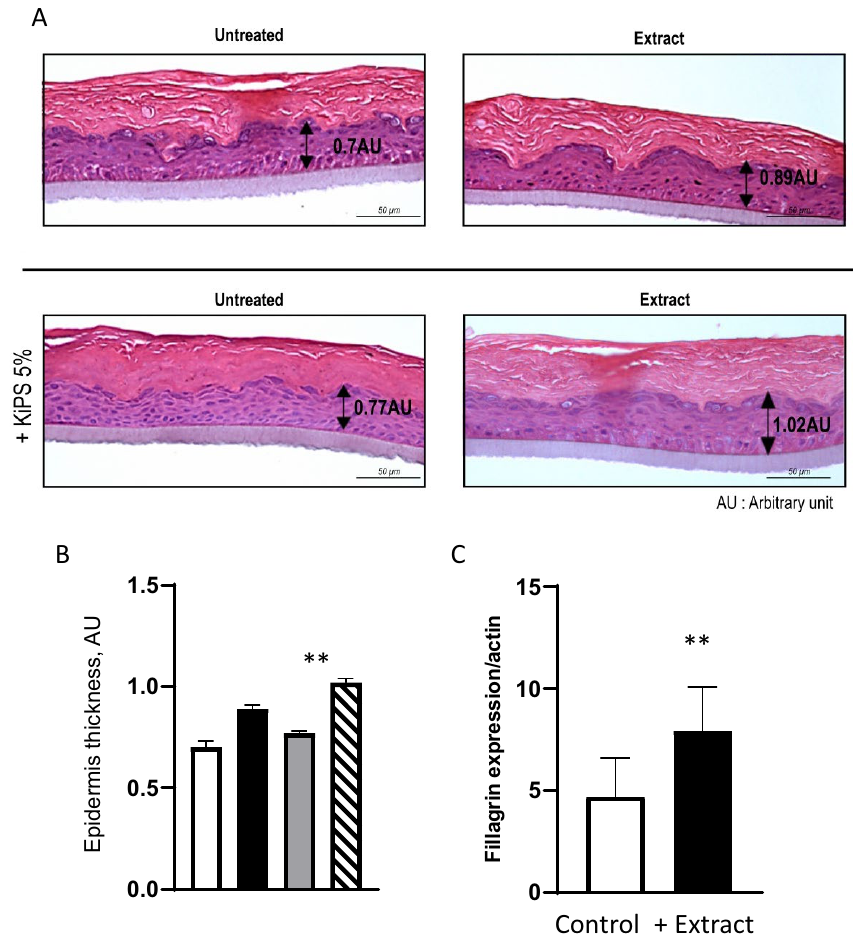
Figure 4. Morphological study of RHE-KiPS after treatment with plant extract. ( A ) Hematoxylin and Eosin staining at Day 13 to study RHE morphology: hematoxylin stains basophilic structures such as the nuclei in blue and purple; Eosin stains acidophilic structures such as the cytoplasm in pink. The upper panel shows RHEs derived from 100% non-treated (left) or pre-treated NHKs (with 1% JPPS extract treatment 48 h before reconstruction). The lower panel shows RHEs derived from non-treated NHKs with the addition of 5% KiPS-40, non-treated (left), or incubated with the 1% JPPS extract added 48 h before the reconstruction commenced (right). ( B ) Quantification of epidermis thickness of non-treated (white bar) or pre-treated with JPPS extract NHK (black bar), non-treated NHKs with the addition of 5% KiPS-40 (grey bar) or treated (dashed bar), To measure the epidermal thickness of, measurements of viable cellular layers were conducted on three reconstructed tissue after H&E staining (Three pictures per condition were taken and 6 measurements of the thickness were calculated per picture. The measurement is the mean of the three pictures. AU arbitrary unit. (mean ± sem; n = 3; * P < 0.05, with Student’s t -test). ( C ) Quantification of fillagrin by WES analysis. 5% KiPS- 40 treated (black bars), and non-treated extract (white bars) were added the day of the reconstruction and RHEs were grown for 13 days, then RHE protein extraction was performed and filaggrin was quantified bars (mean ± sem; n = 3; * P < 0.05, with Student’s t